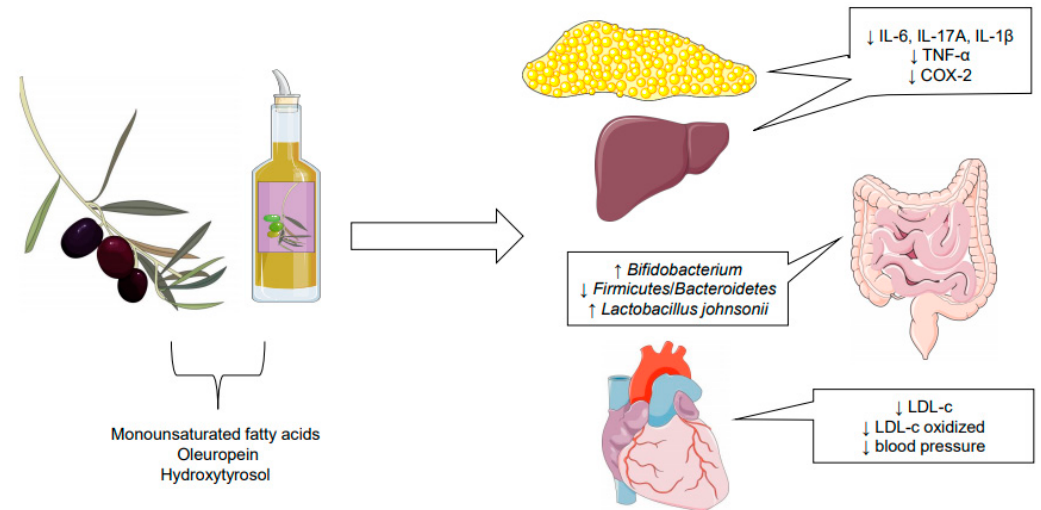
Figure 1. Tumor necrosis factor (TNF- α ); interleukin-6 (IL-6); interleukin-17A (IL-17A); interleukin-1 β (IL-1 β ); cyclooxigenase-2 (COX-2); low-density lipoprotein cholesterol (LDL-c).